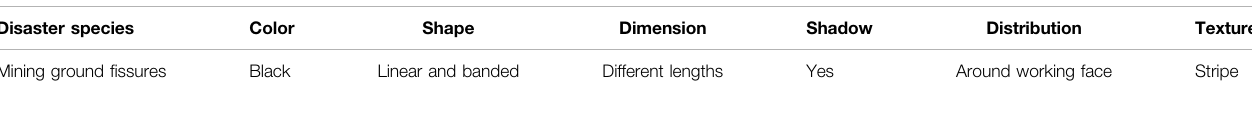
TABLE 3 | Interpretation characteristics of ground fi